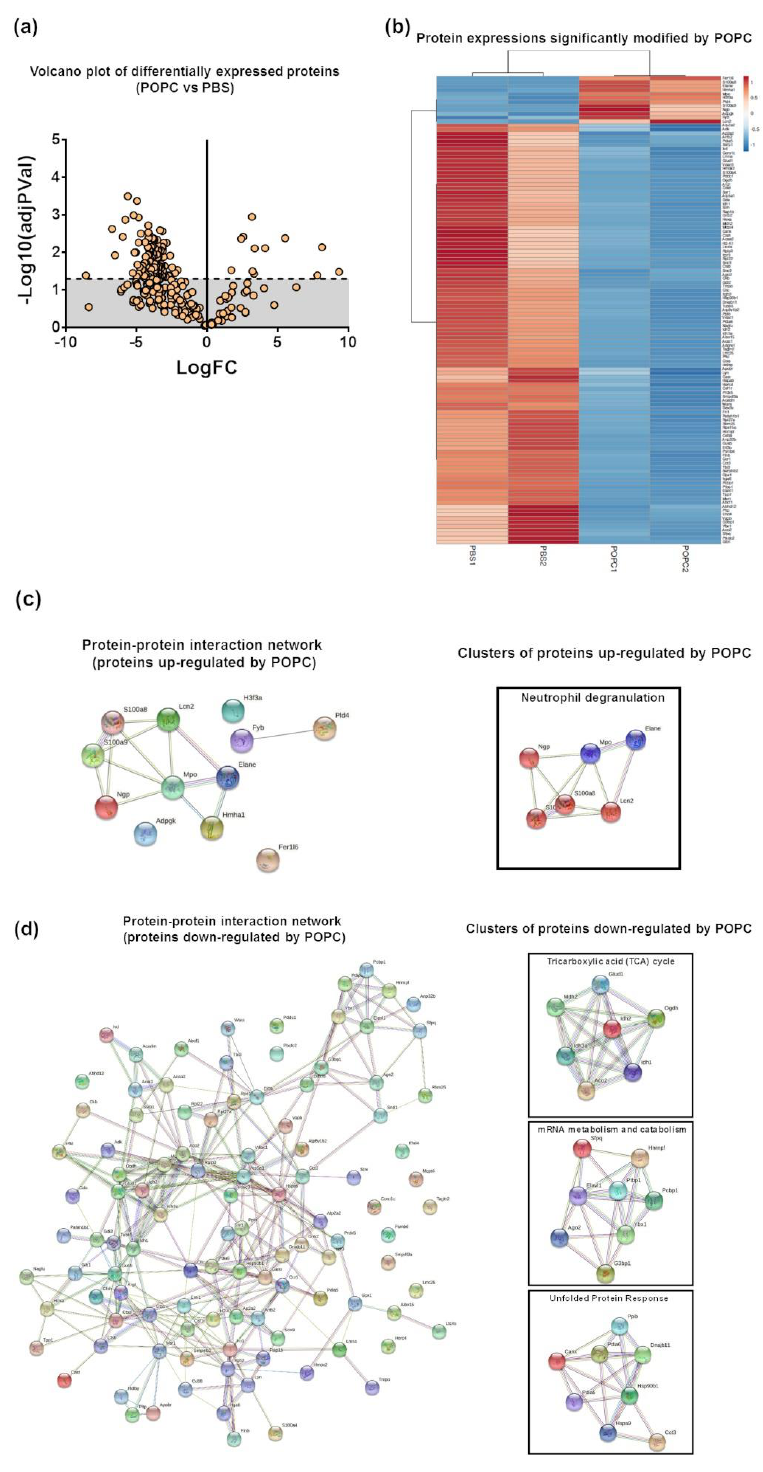
Figure 9. POPC liposomes significantly modify the proteome of peritoneal cells . CD-1 mice were